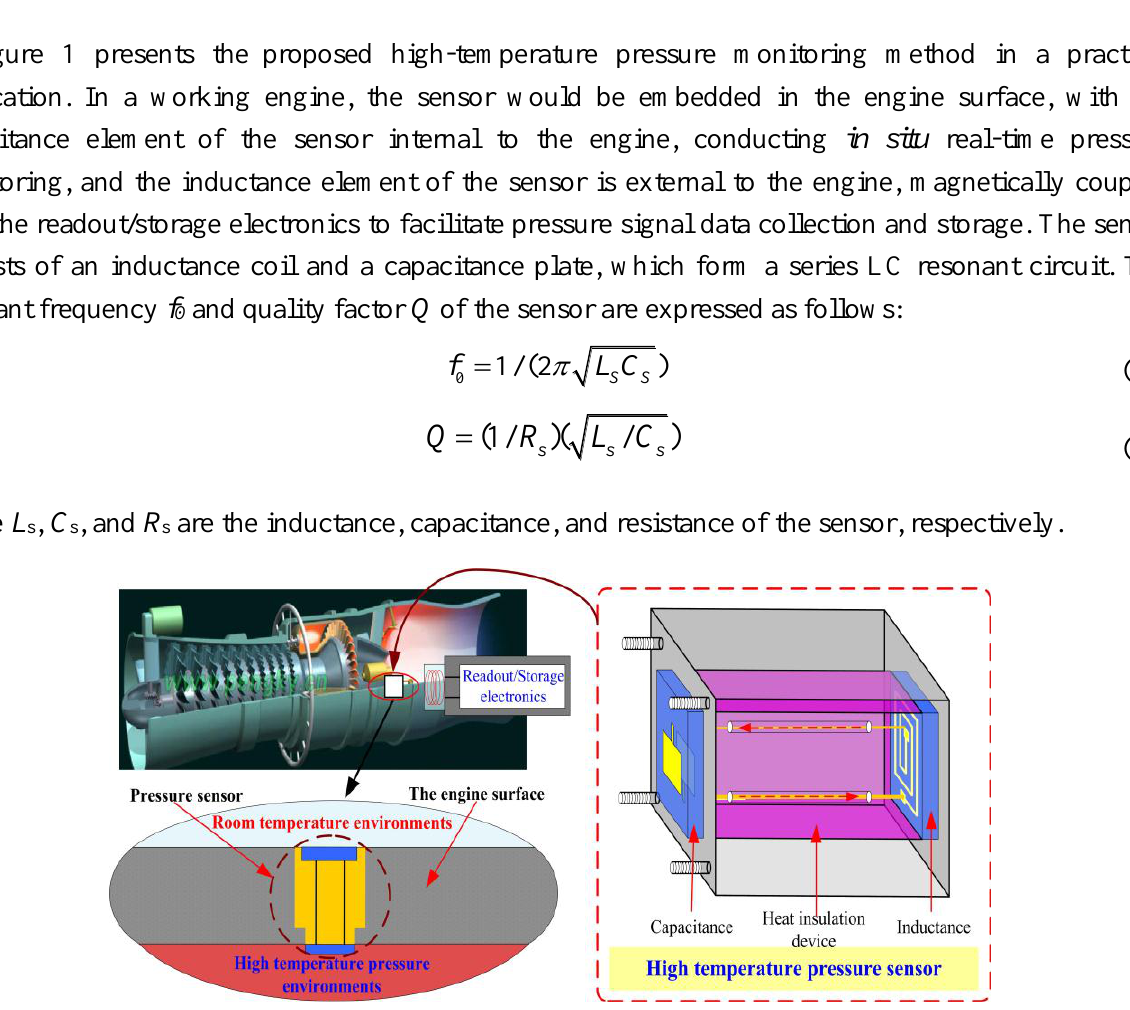
Figure 1. Proposed high-temperature pressure monitoring method in a practical